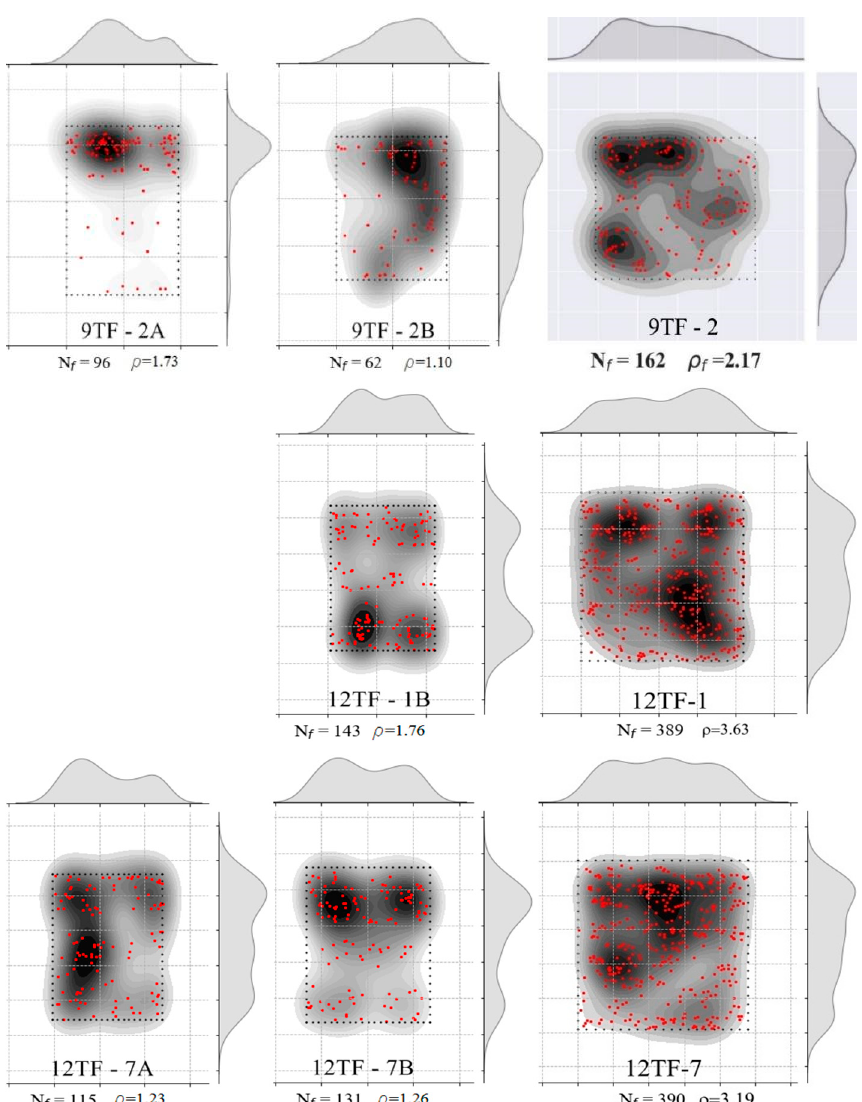
Figure 23. Fiber density and distribution of top-flange specimens of the longitudinal direction. Left column corresponds to prism A (shear), the middle column corresponds to prism B (shear) and the right column corresponds to the flexural case.